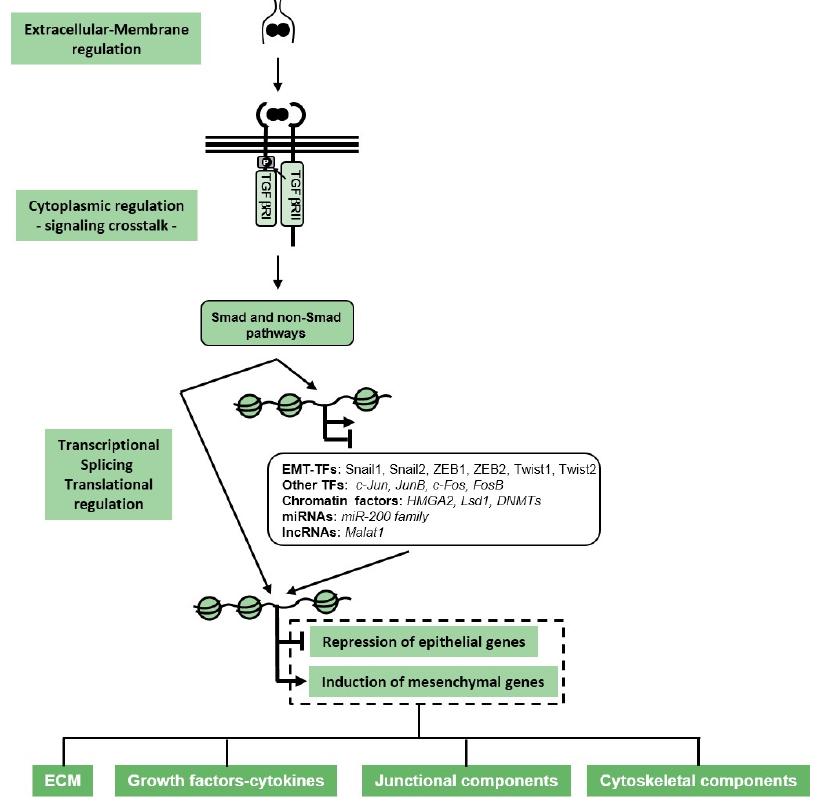
Figure 2. Summary of TGF β signaling during EMT. Inactive TGF β ligand (bound to its N ‐ terminal